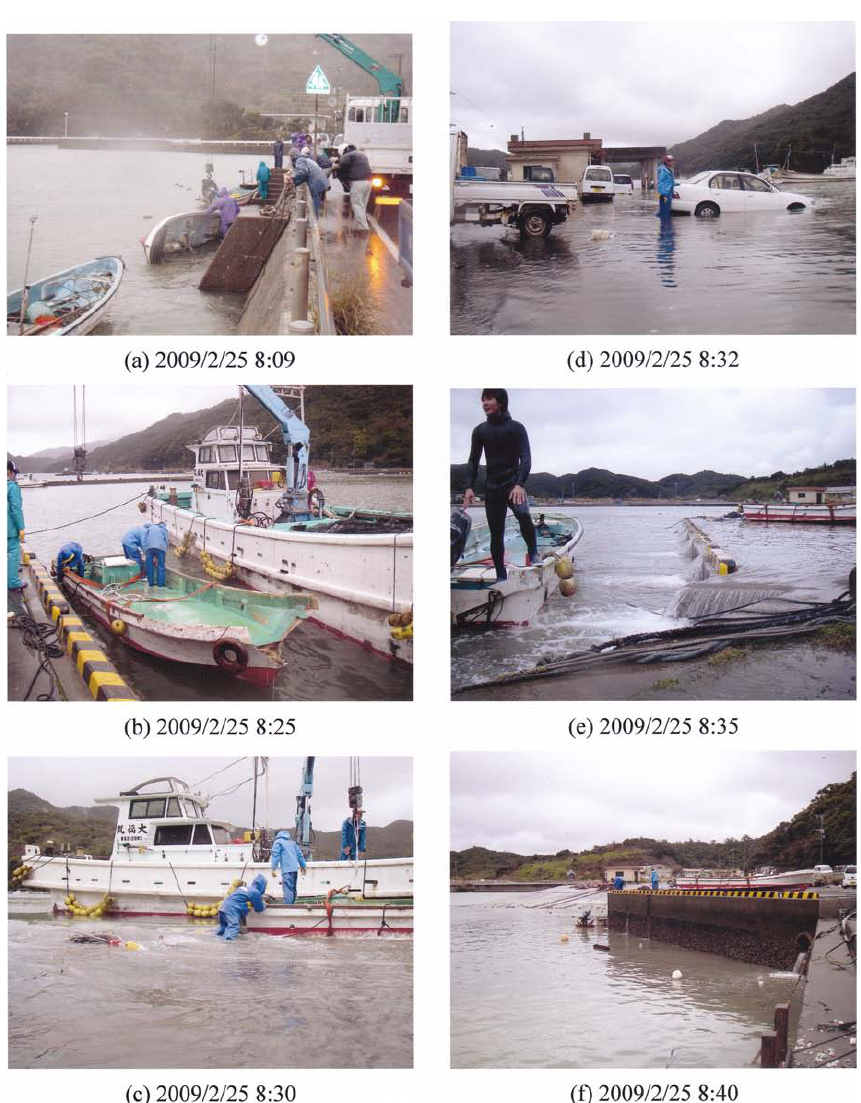
Fig. 3. Sequence of photographs taken on 25 February 2009 at the Oshima port, Kamikoshiki Island, provided by the Kamikoshiki Branch Office, Satsuma-Sendai